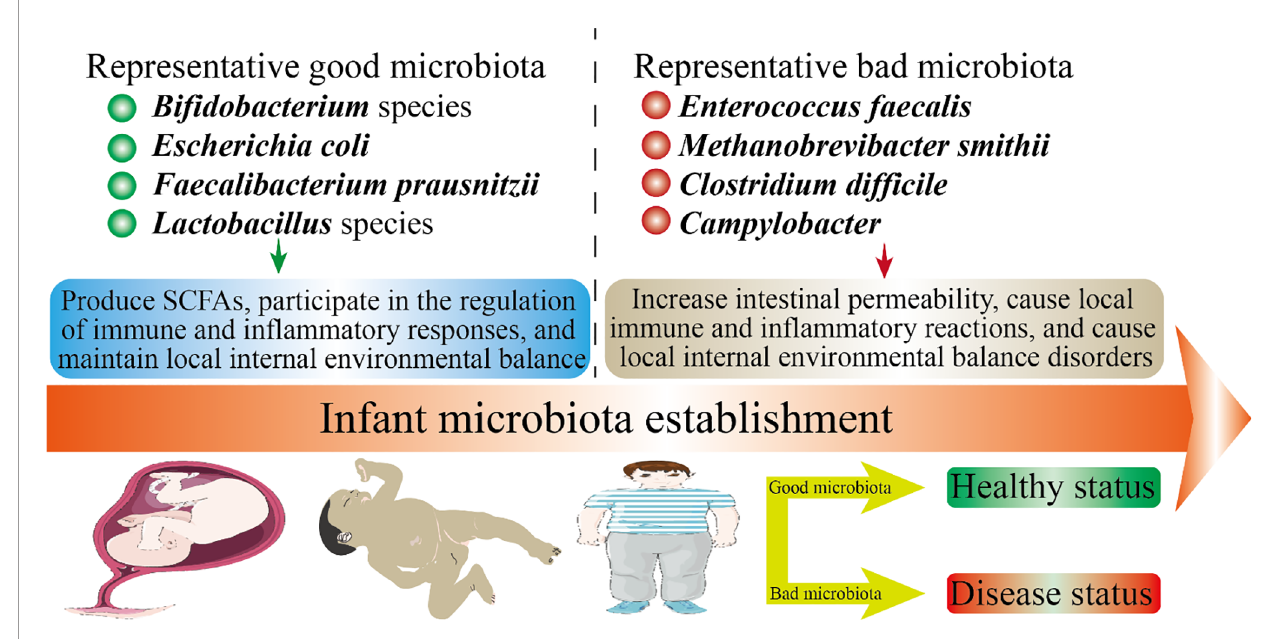
FIGURE 2 | Infant health status and microbiota establishment. The health of offspring is closely related to the microbiota. In this fi gure, we have listed several representative good microbiota and several representative bad microbiota. The microbiota will inhibit the developmental stages throughout the offspring. The mechanism by which the good microbiota is bene fi cial to health may be: produce SCFAs, participate in the regulation of immune and in fl ammatory responses, and maintain local internal environmental balance. The mechanism by which the bad microbiota is harmful to health may be: increase intestinal permeability, cause local immune and in fl ammatory reactions, and cause local internal environmental balance